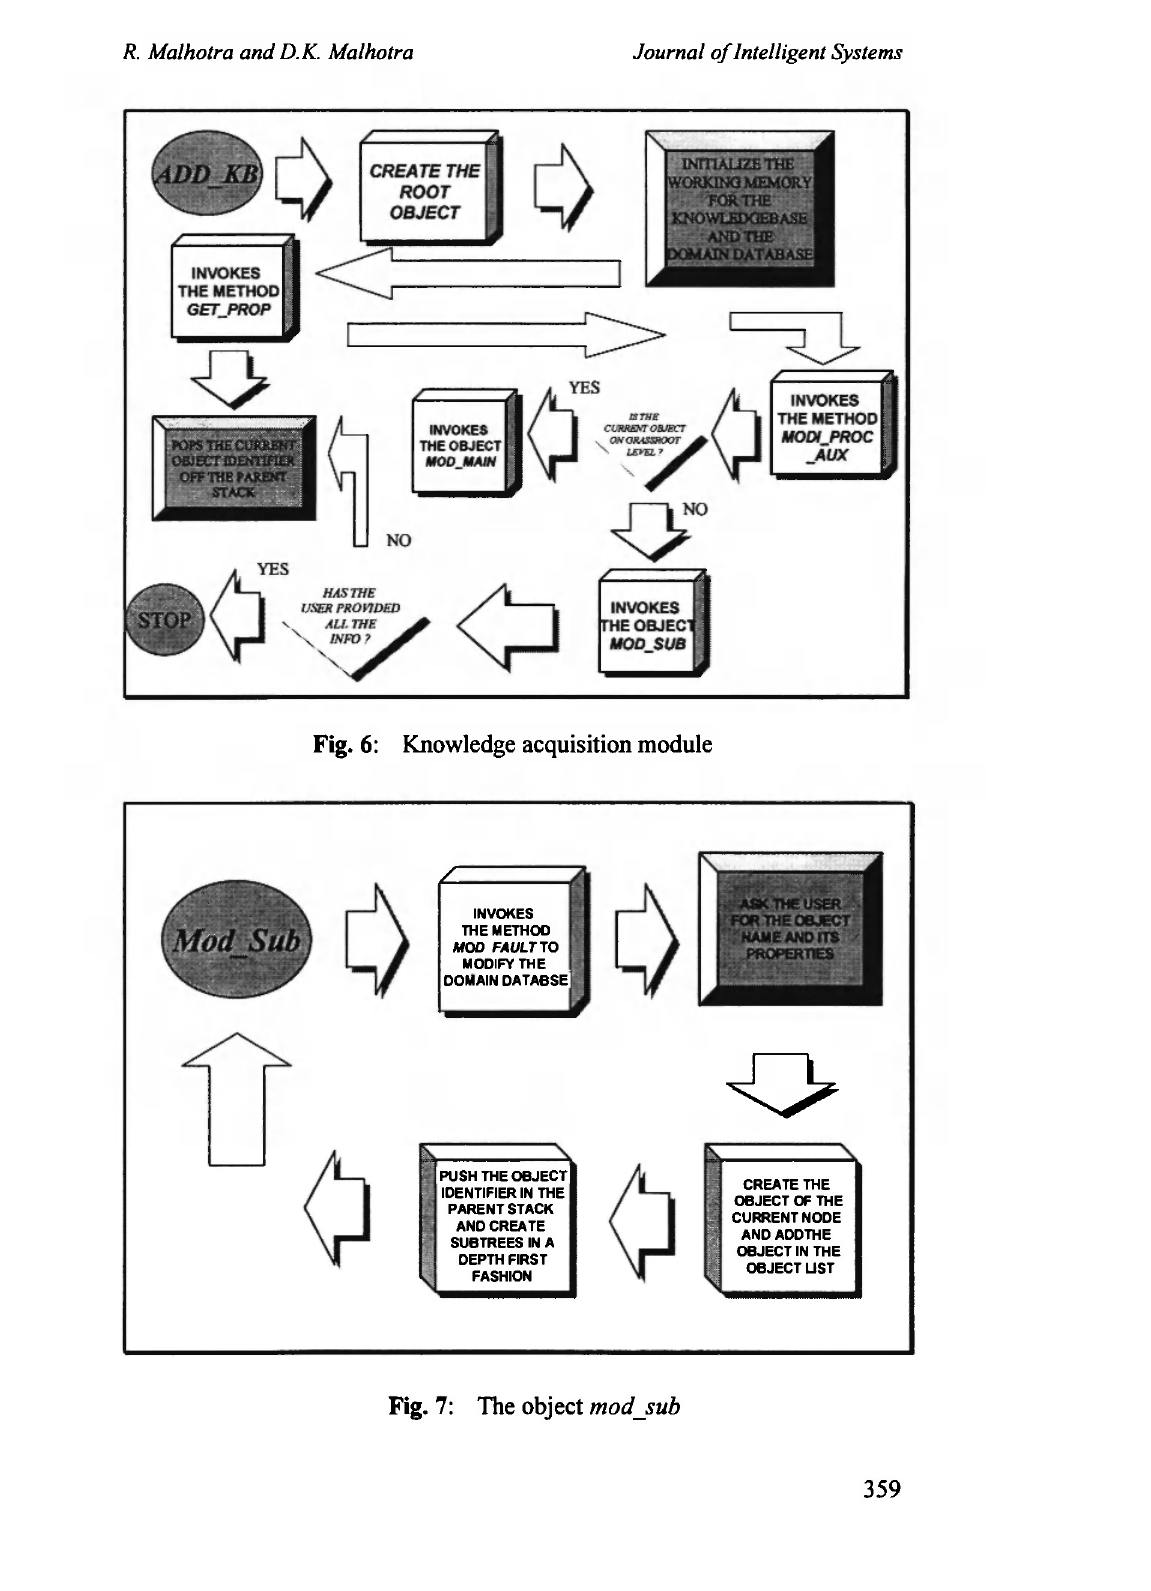
Knowledge acquisition